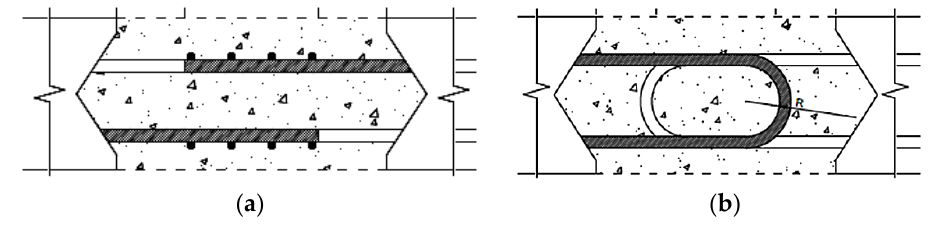
Figure 4. Reinforcement arrangement of the joint: ( a ) Lap splice. ( b ) Loop (U ‐ bar). Table 1 summarizes the respective design value of materials used for the strength design method. Table 1. Design strengths of the material.